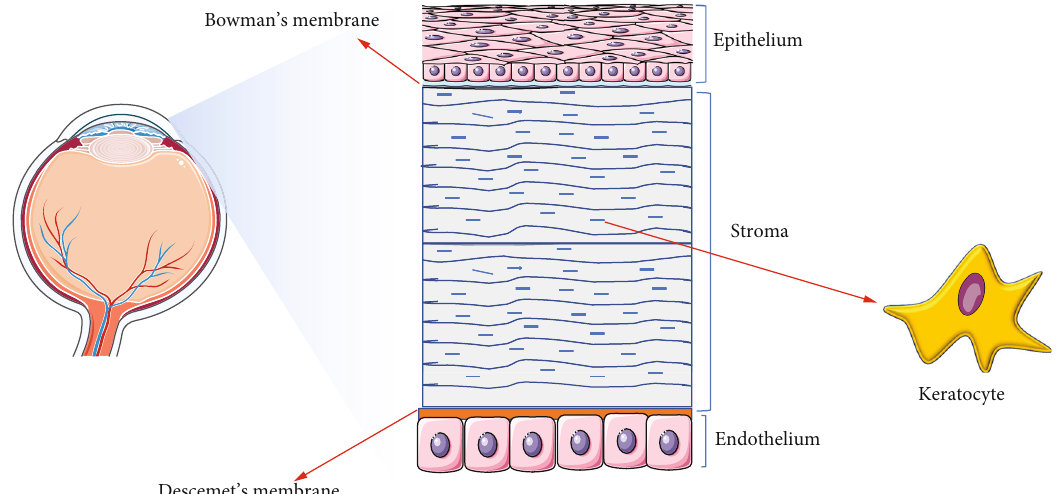
Figure 1: Schematic structure of the cornea. The epithelial layer is the outermost part of the corneal tissue, which sits on Bowman ’ s membrane. The stroma layer is the middle part of the corneal tissue which accounts for 80%-85% of the cornea ’ s thickness and consists of mainly keratocytes. The endothelium layer is the innermost part of the corneal tissue and is connected to the stroma layer by Descemet ’ s